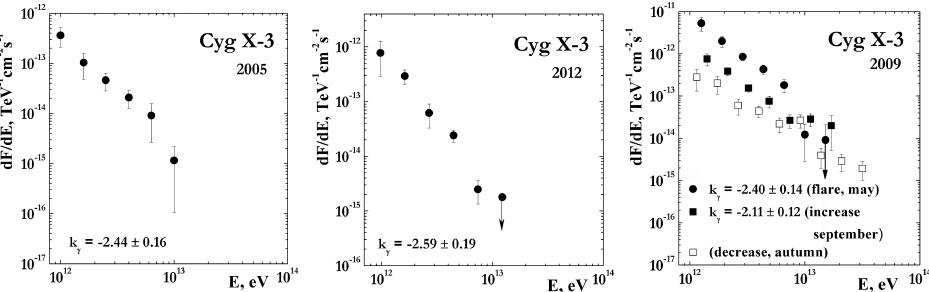
Figure 7. Differential spectra of the gamma-ray emission from Cyg X-3: low-intensity periods of the 2005 and 2012 years and during the flux increases and decrease of the